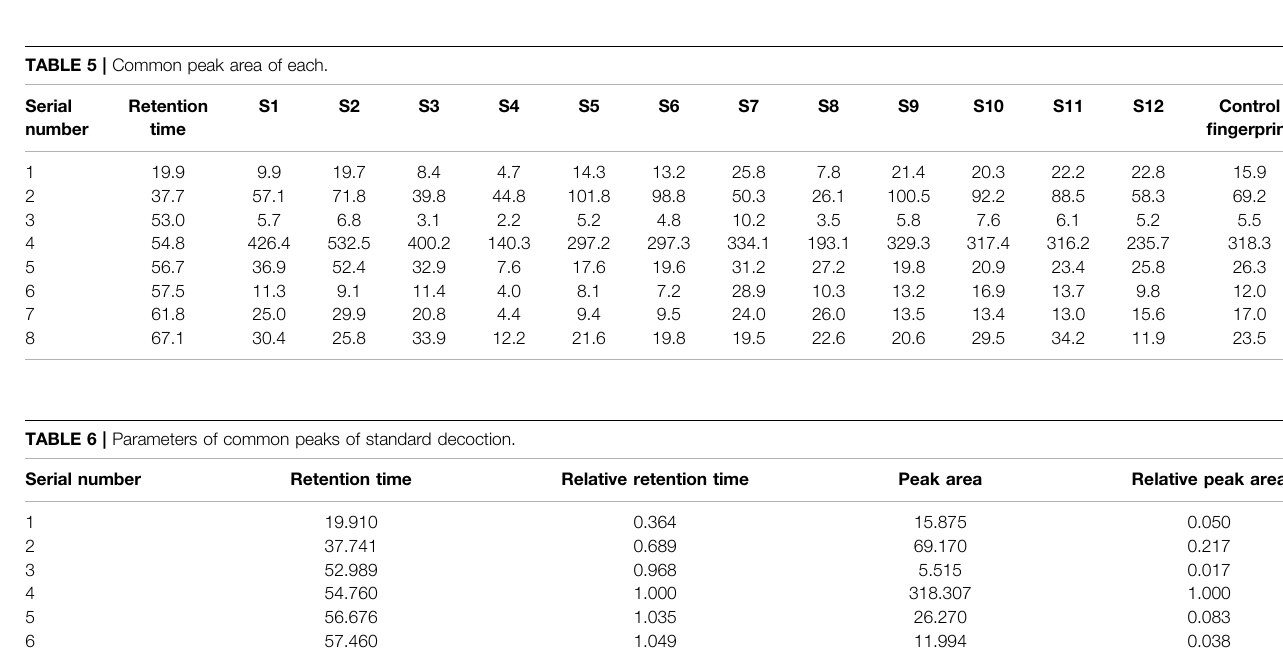
FIGURE 5 | Comparison of characteristic spectra and con fi rmation of common peaks.